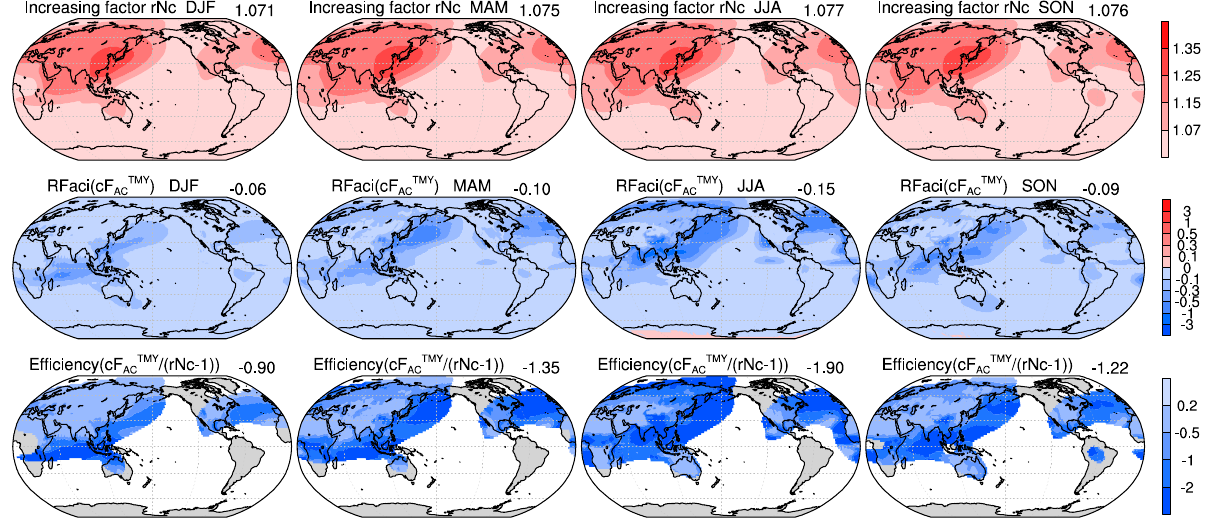
Figure 6. As in Figure 5 but for the present-day (year 2000) droplet number increasing factor (rNc, upper panels ), the instantaneous radiative forcing from aerosol–cloud interactions (RFaci, middle panels ), and the efficiency for aerosol–cloud interactions ( lower panels ). The area with a low anthropogenic aerosol burden (rNc < 1.07) is masked.